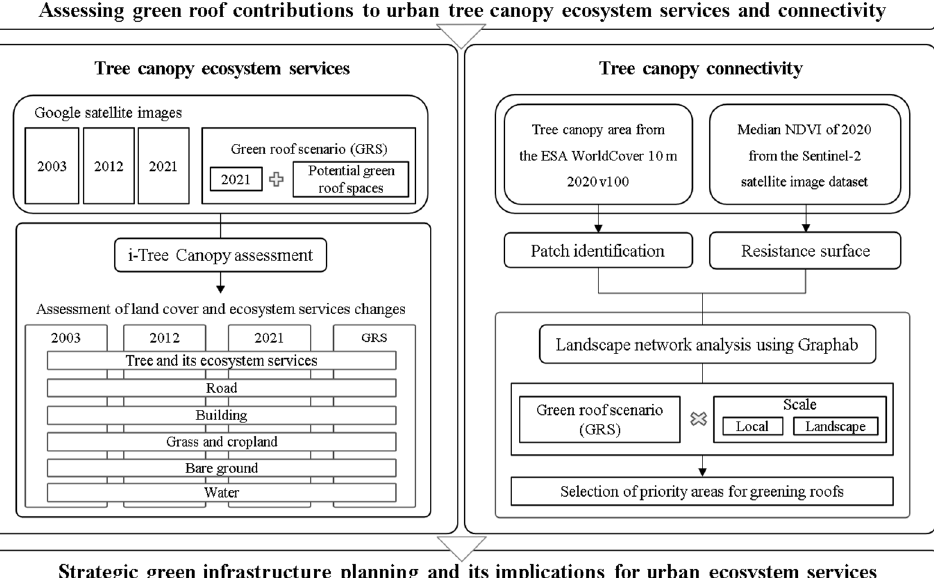
Figure 3. A flowchart illustrating the procedures followed in the present study.